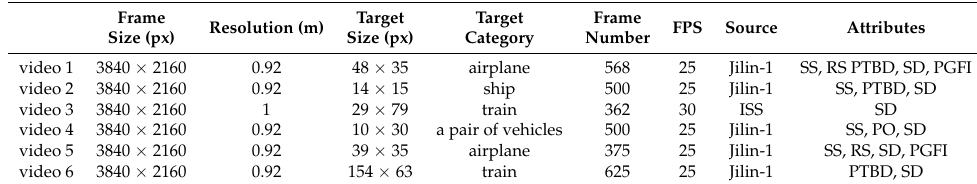
Figure 4. The testing datasets used in the experiments. There are six satellite videos, and the tracking objects consist of airplane, ship, train, and a pair of vehicles. Table 2. The detailed descriptions of six experimental satellite